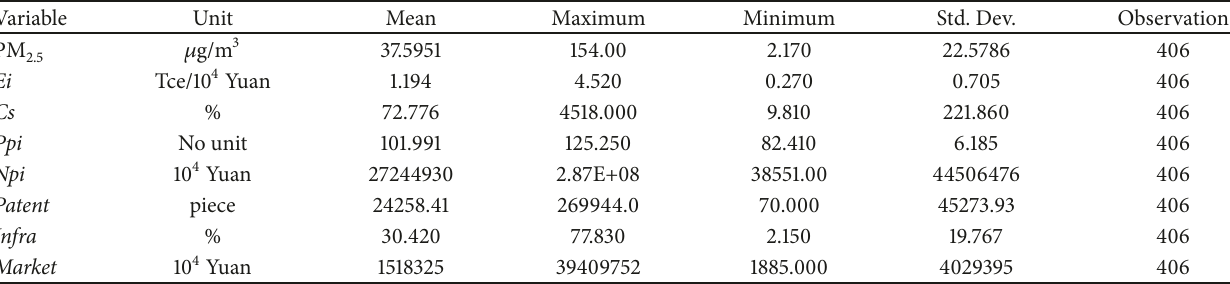
Table 1: Descriptions of all variables in econometric model.